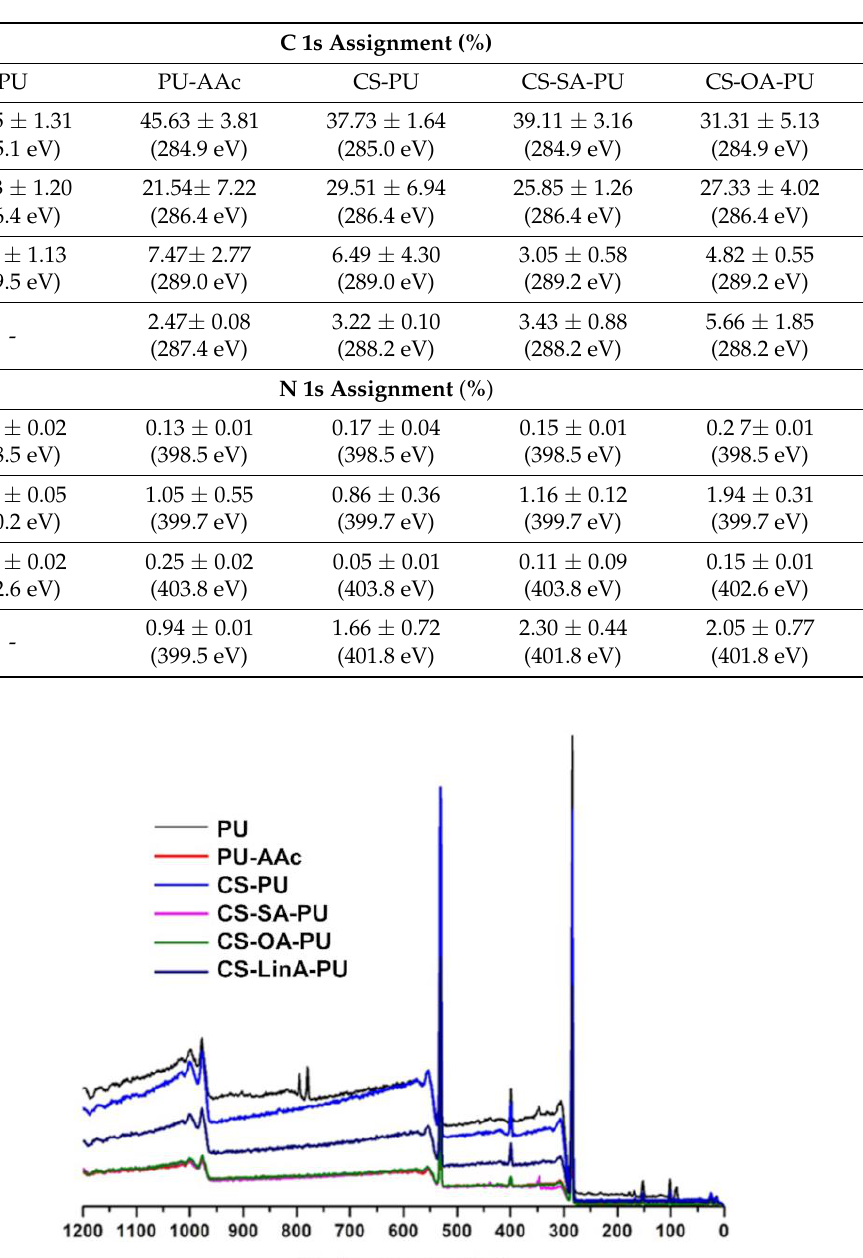
Table 1. Percentage contributions of distinctive chemical bonds in the high-resolution C 1s and N 1s spectra.